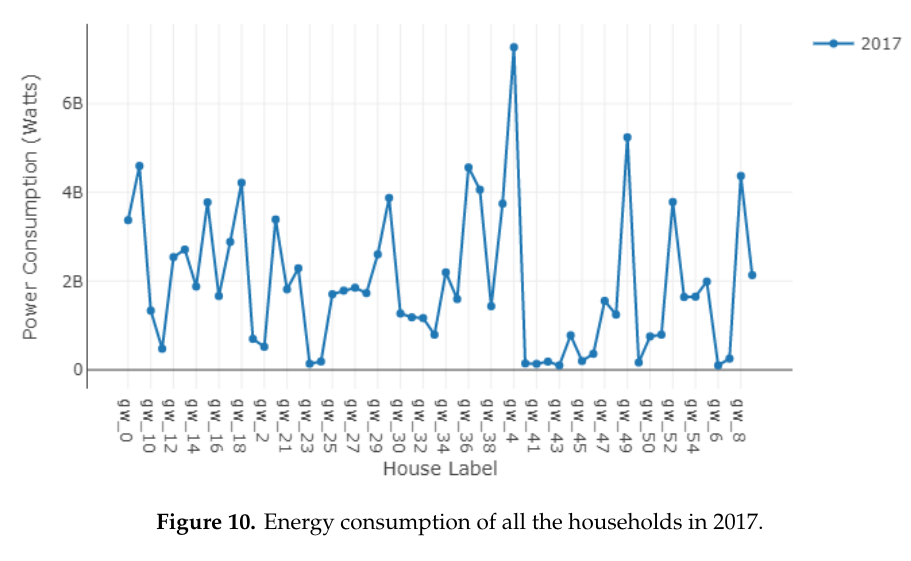
Figure 10. Energy consumption of all the households in 2017.